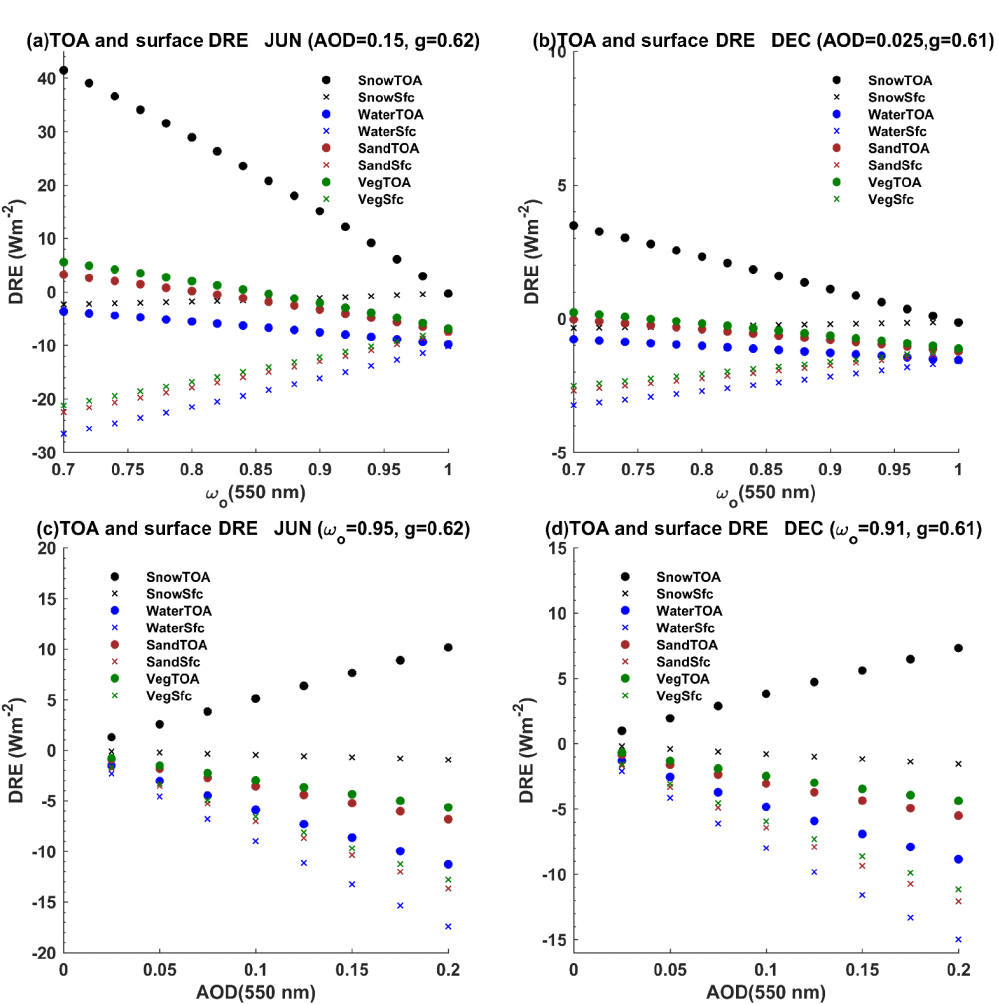
Figure 8. TOA and surface DRE versus ω 0 and AOD for JUN and DEC, for each of the four surface types (snow, seawater, sand, and